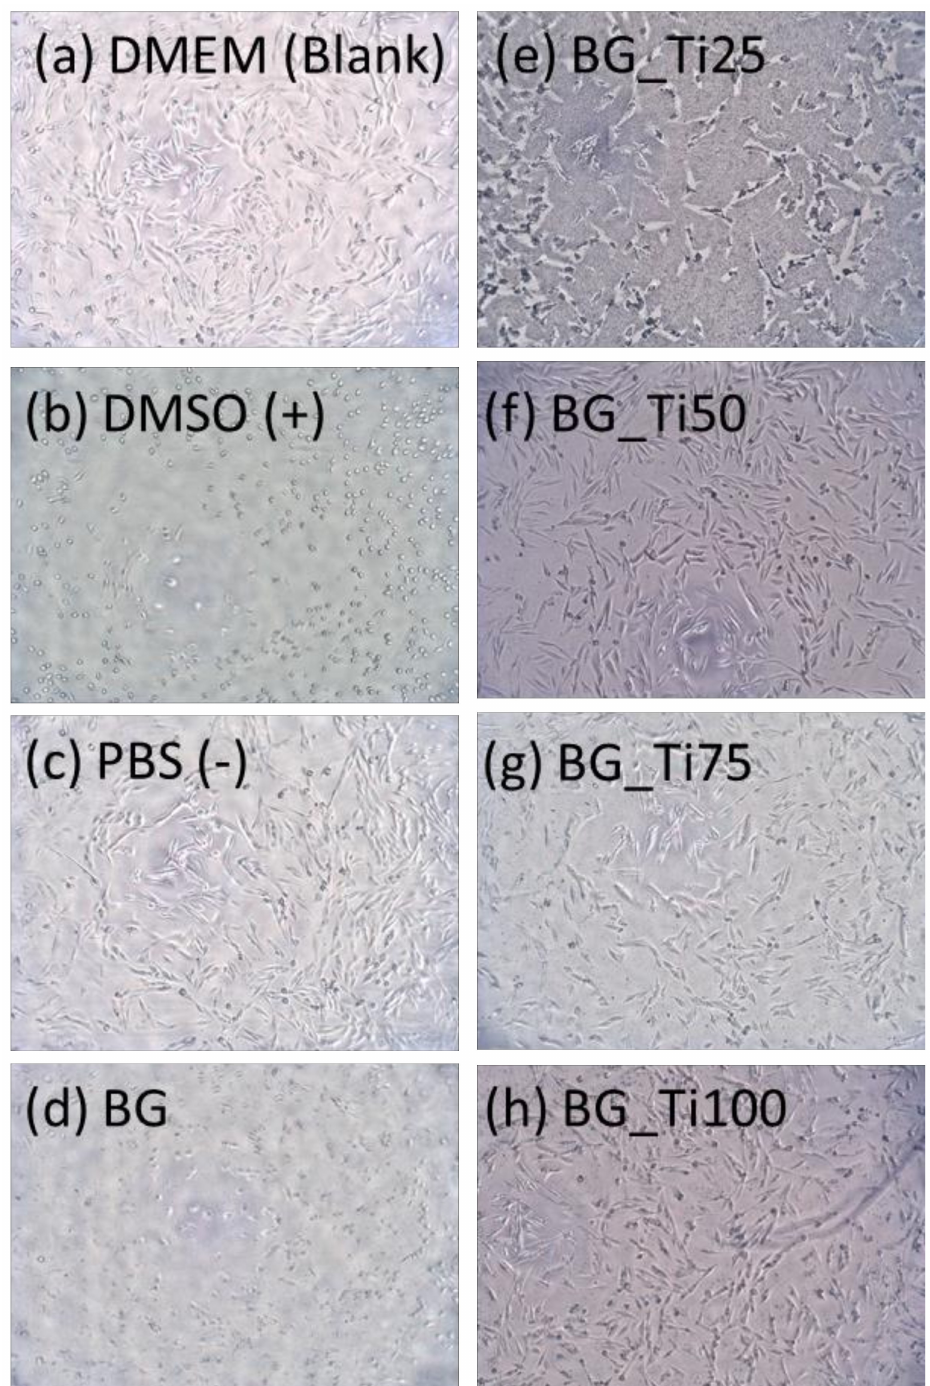
Figure 5. The cell morphology of MG63 cells incubating for 1 day in ( a ) Dulbecco’s modified Eagle medium (DMEM); ( b ) dimethyl sulfoxide (DMSO); ( c ) phosphate buffered saline (PBS), ( d ) the extraction of bioglass; and ( e – h ) the extractions of bioceramics composed of silica and titanium oxide with various concentrations of titanium